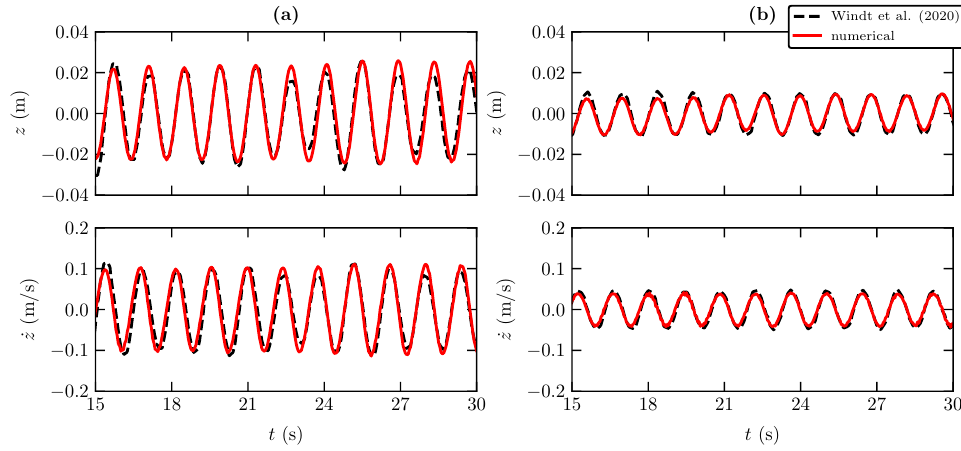
Figure 4. Time series of position (top) and velocity (bottom) of the PTO system for Test 2 with ( a ) D = 0 and ( b ) D = 200 Nms